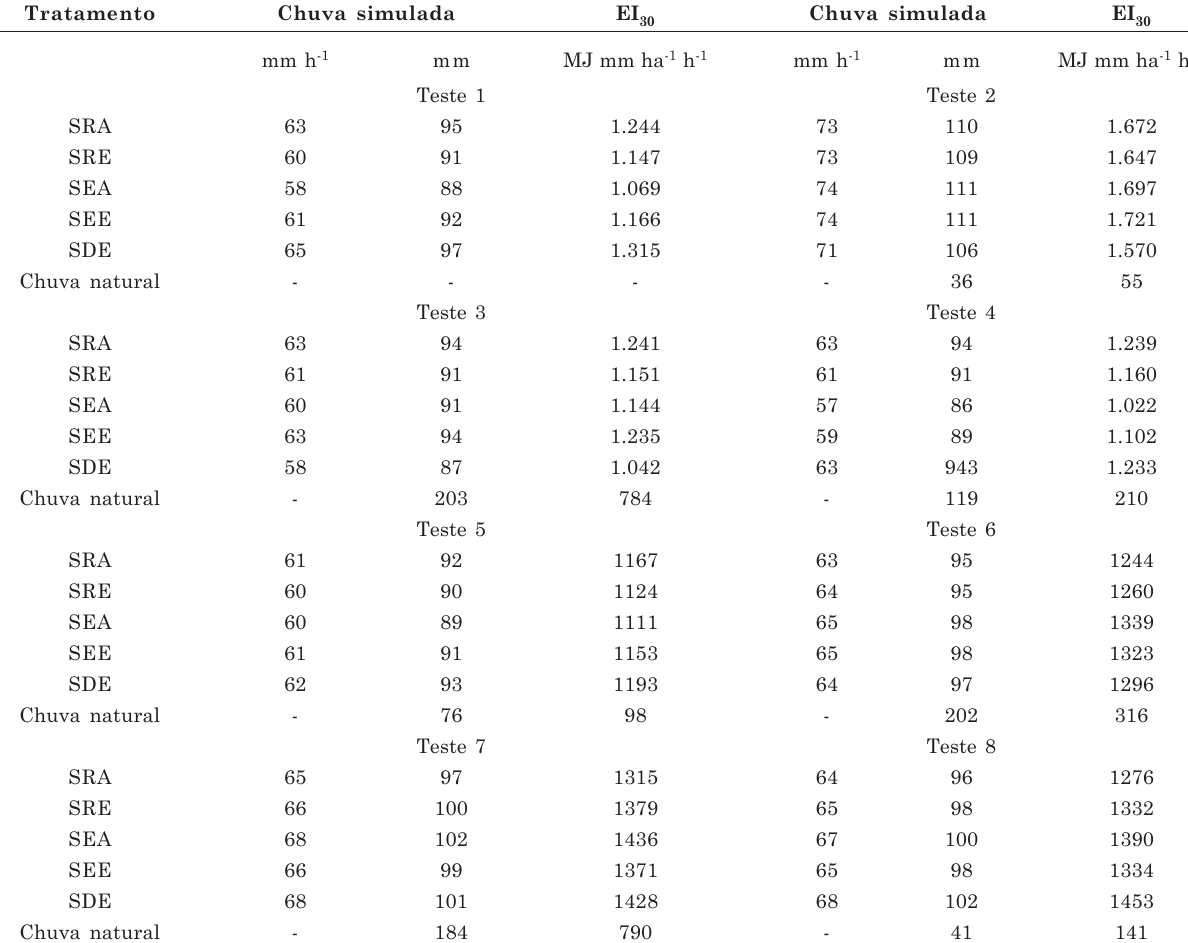
Quadro 2. Intensidade e altura das chuvas simuladas, aplicadas em cada tratamento, e altura de